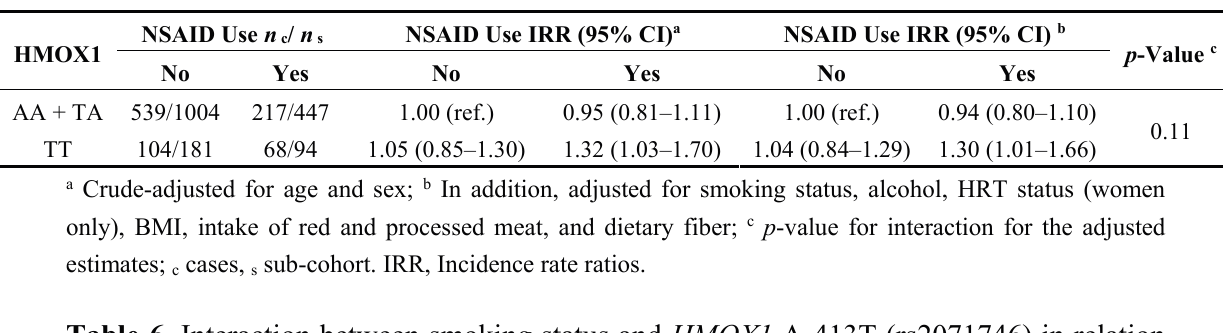
Table 5. Interaction between NSAID use and HMOX1 A-413T (rs2071746) in relation to colorectal cancer risk.